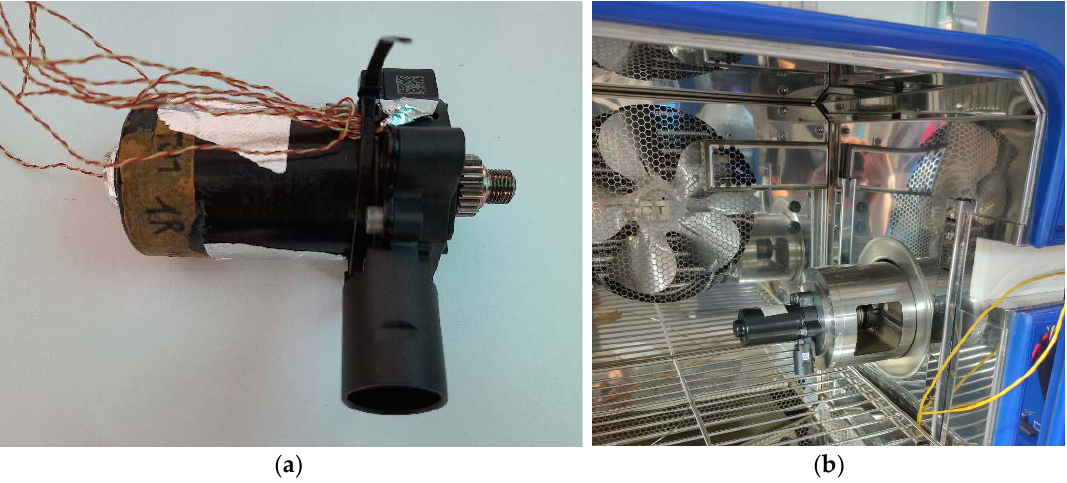
Figure 2. Setups for thermal tests: ( a ) pulse tests; ( b ) load cycle tests. The performed tests can be grouped into pulse tests and load cycle tests. A pulse test consists of injecting a dc current into the stator winding until the maximum admissible temperature is reached. In some cases, when low values of dc currents are injected in the motor, the maximum temperature is never reached and, therefore, the pulse duration is arbitrary; these tests are considered as steady-state tests. The injection of a dc current in a three-phase star-connected winding with a non- accessible common point is feasible in two different ways. The two configurations that allow such supply are shown in Figure 3 and referred to here as configuration A (Figure 3a) and configuration B (Figure